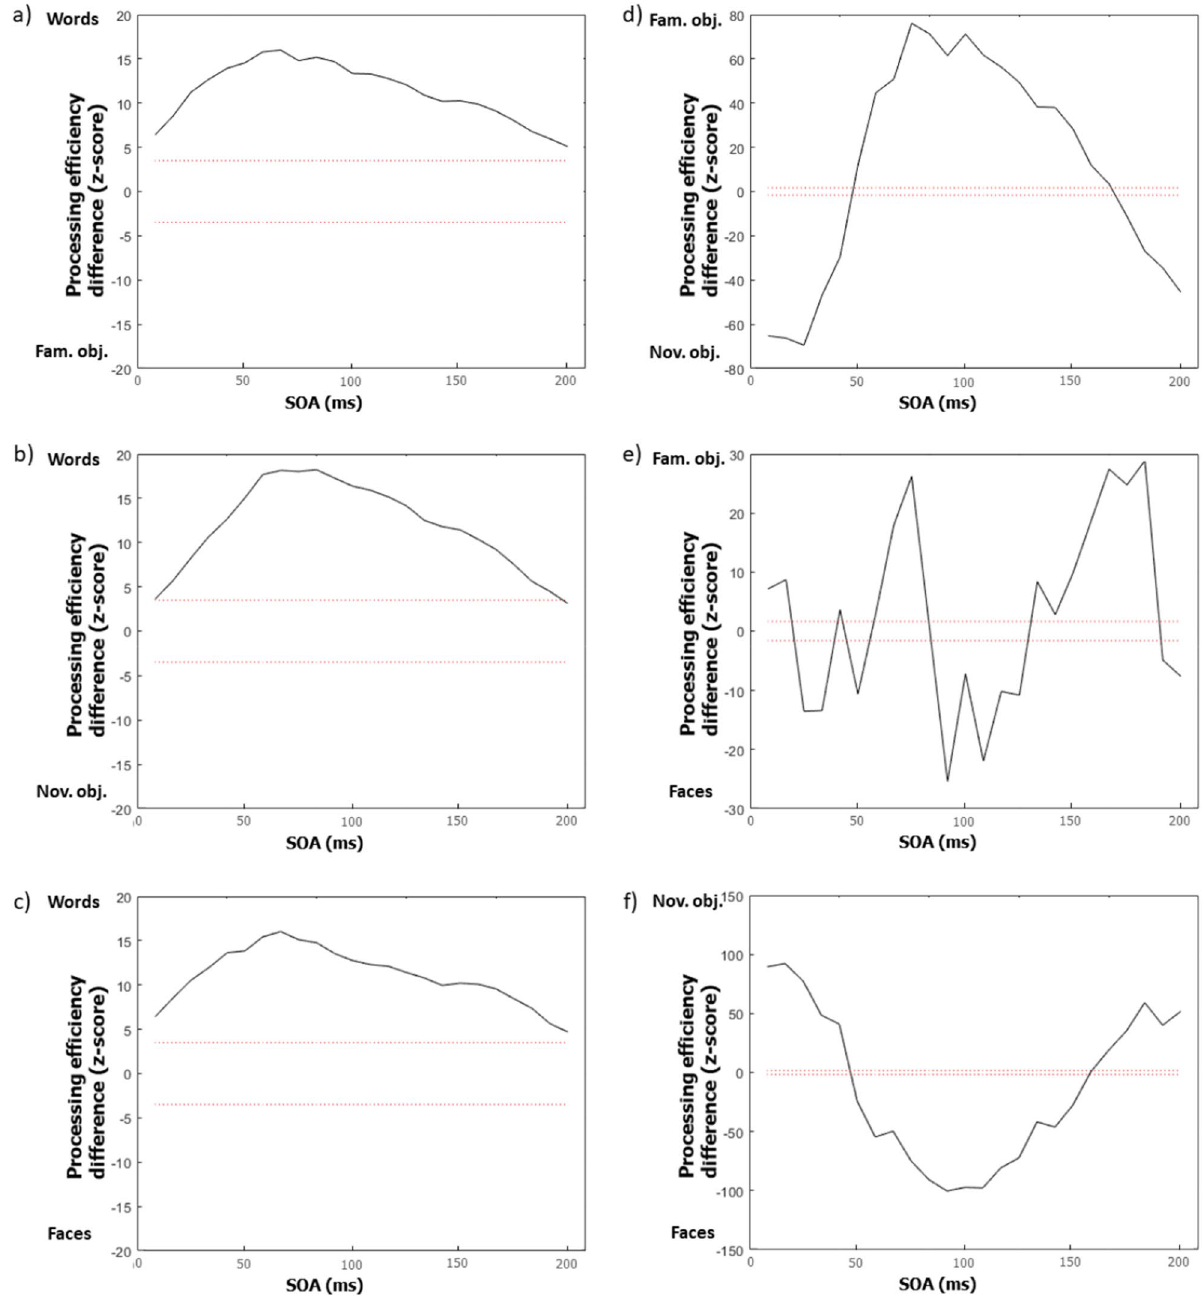
Figure 4. Contrast classification images in the time domain. Each graph expresses the differences in processing effectiveness (in Z scores) as a function the time elapsed since target onset (stimulus onset asynchrony; SOA) for a particular pair of tasks (defined by stimulus class). The ends of the ‘Processing efficiency difference’ scales are labelled by one of the stimulus classes being contrasted and difference values close to one end or the other end favour the corresponding stimulus class. All possible pairs of tasks have been contrasted: ( a ) words minus familiar objects; ( b ) words minus novel objects; ( c ) words minus faces; ( d ) familiar objects minus novel objects; ( e ) familiar objects minus faces; ( f ) novel objects minus